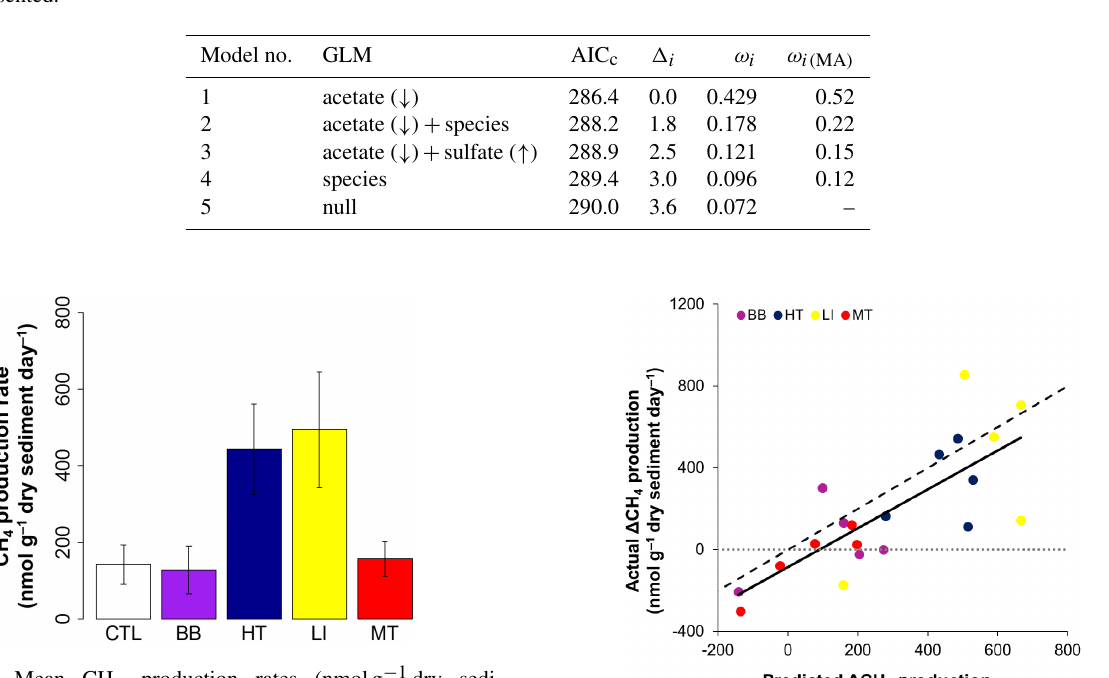
Table 4. Generalized linear models (GLMs) wherein (cid:49) CH 4 production rate (treatment minus control) is the response variable and the macrophyte species added (buckbean, horsetail, lily, or marestail), porewater acetate availability, and total sulfate availability are potential factors. Positive ( ↑ ) or negative effects ( ↓ ) of continuous factors are indicated. Models are ranked in order of the lowest Akaike information criterion corrected for low samples sizes (AIC c ) along with delta AIC c ( (cid:49) i ) and Akaike weights ( ω i ) before and after model averaging (MA). The null model (intercept only) was not included in the model averaging, and the three models with a larger AIC c than the null model are not presented.